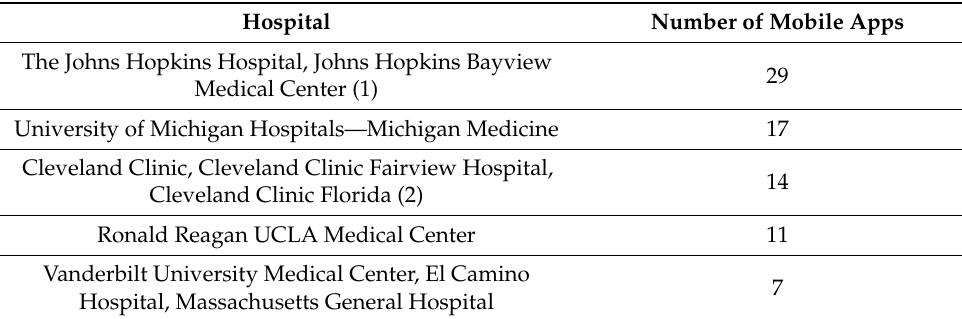
Table 2. Best hospitals by number of mobile apps.